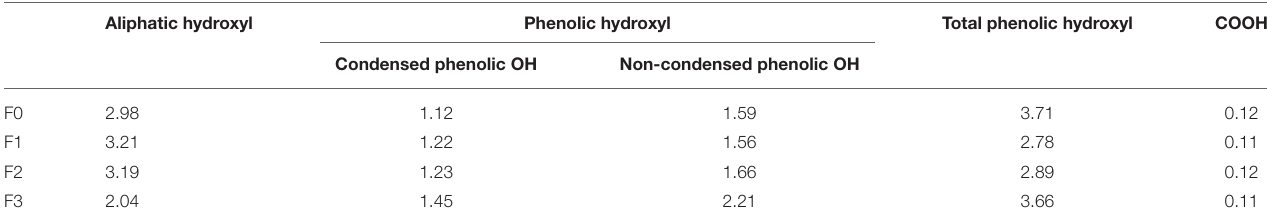
TABLE 3 | The contents of functional groups in lignin fractions (mmol/g).